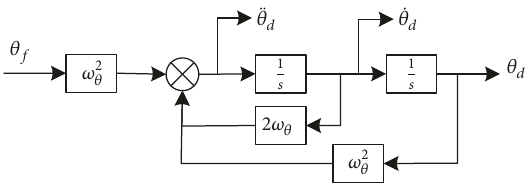
Figure 2: Second-order system structure block